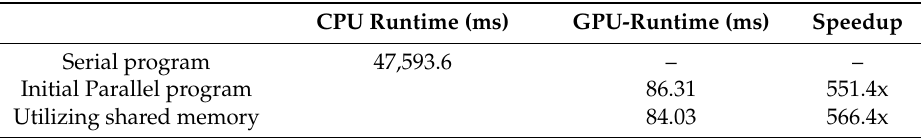
Table 2. Runtime and speedup for the GPU ‐ based SDCSM program with coalesced global memory access optimization.